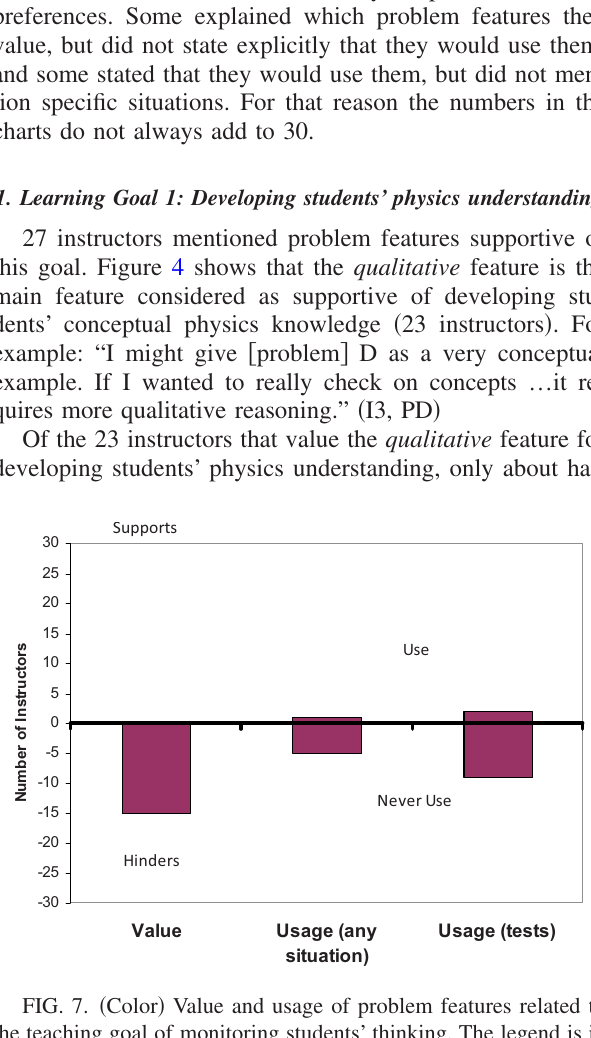
FIG. 9. (cid:1) Color (cid:2) Value and usage of problem features related to the teaching goal of leading students through problems. The legend is in Fig.